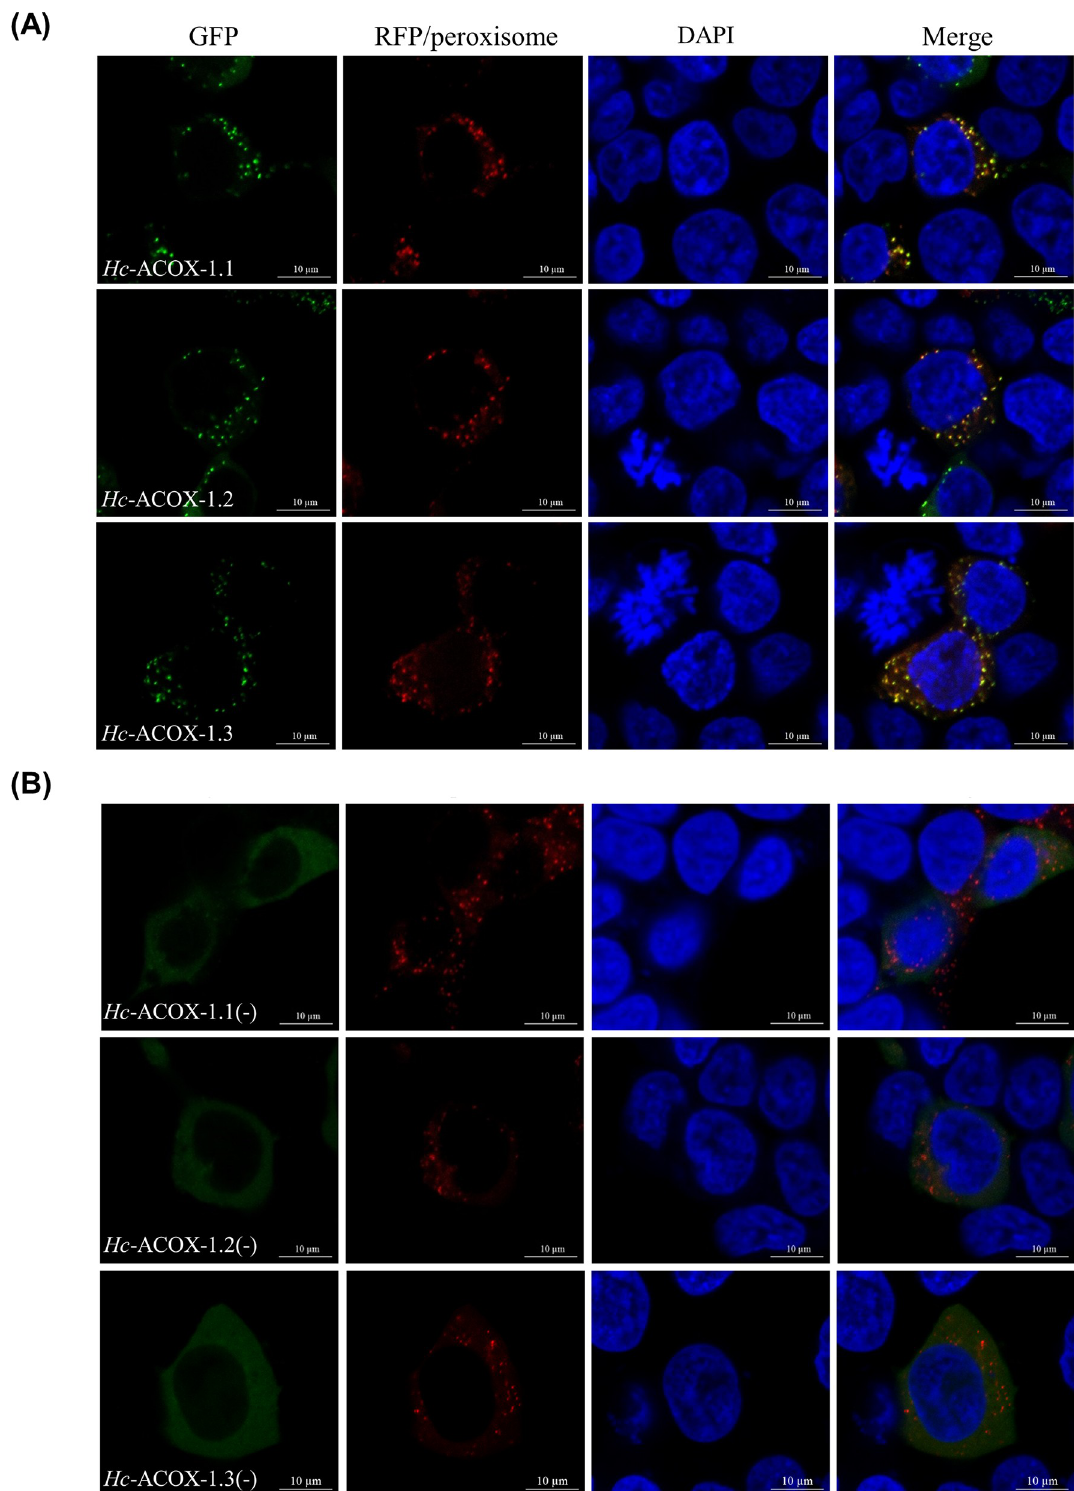
Fig 3. Co-localisation of Hc -ACOX-1 and peroxisomes in HEK293T cells. (A) Subcellular localisation of Hc -ACOX-1 and peroxisomes in HEK293T cells. (B) Subcellular localisation of Hc -ACOX-1 without peroxisomal targeting signal type 1 (PTS1) and peroxisomes in HEK293T cells. Hc -ACOX-1 without PTS1 is designated as Hc -ACOX-1 (-). Green fluorescent protein (GFP)-fused